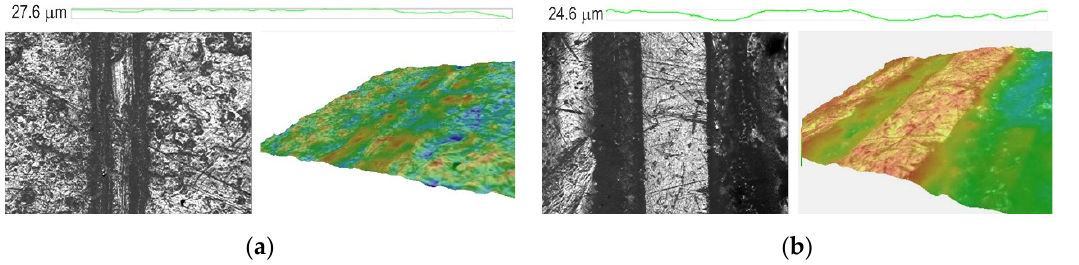
Figure 13. 2D and 3D images and a profile of the PCL/PLA/CF blends: ( a ) 70/30/0 and ( b ) 70/30/3 (magnification 40×).